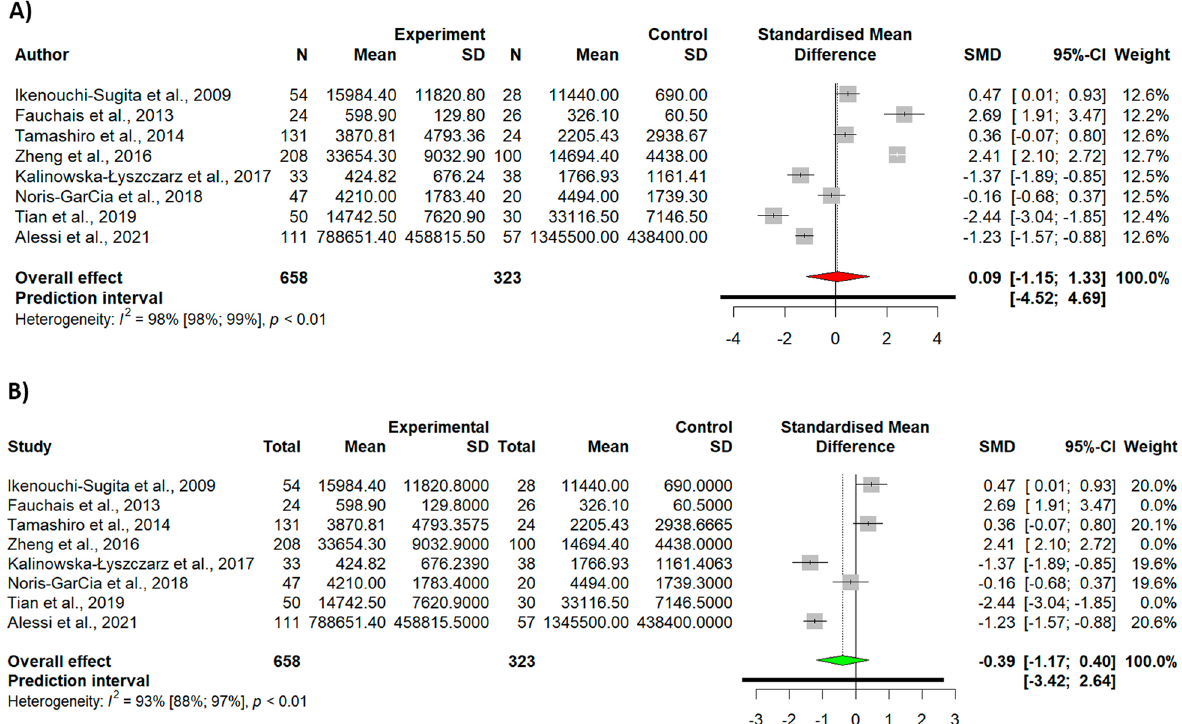
Fig. 2 A Forest plot of meta-analysis of BDNF levels in SLE patients compared to controls., B Forest plot of meta-analysis of BDNF levels in SLE patients removing